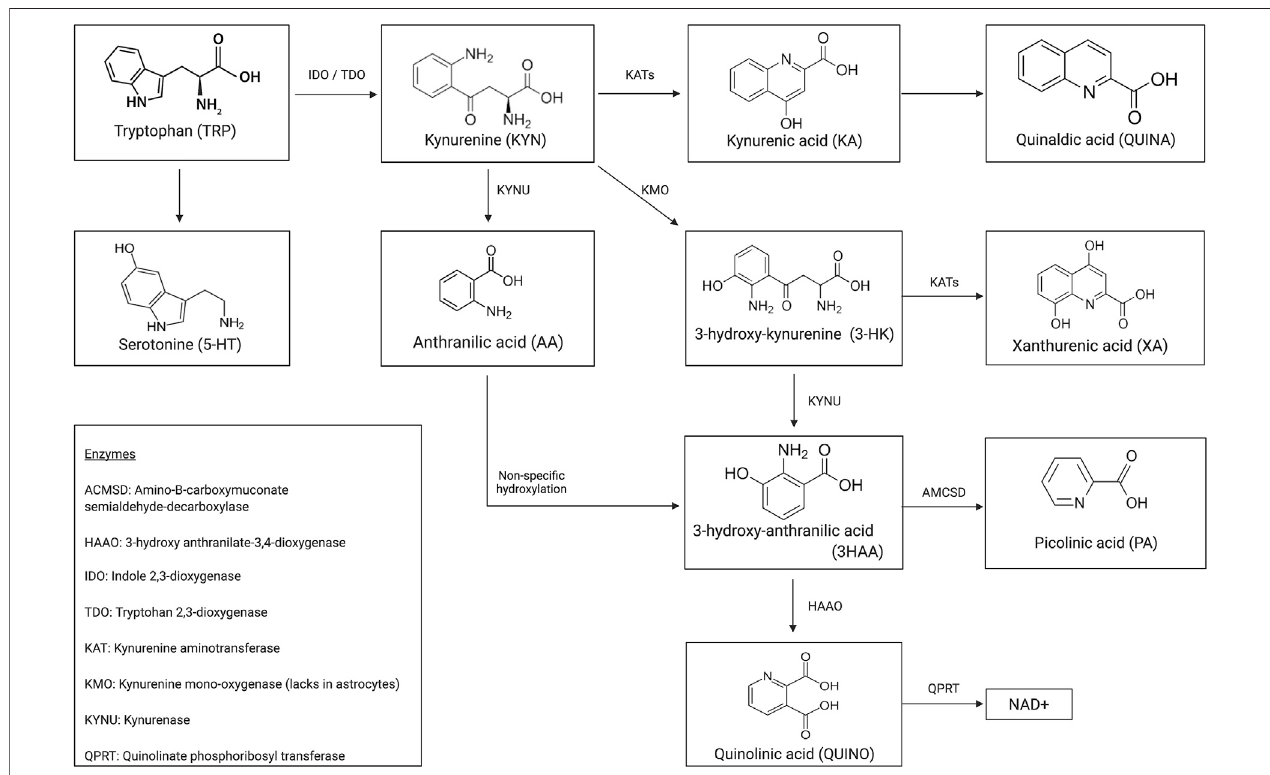
FIGURE 1 | Schematic representation of the kynurenine